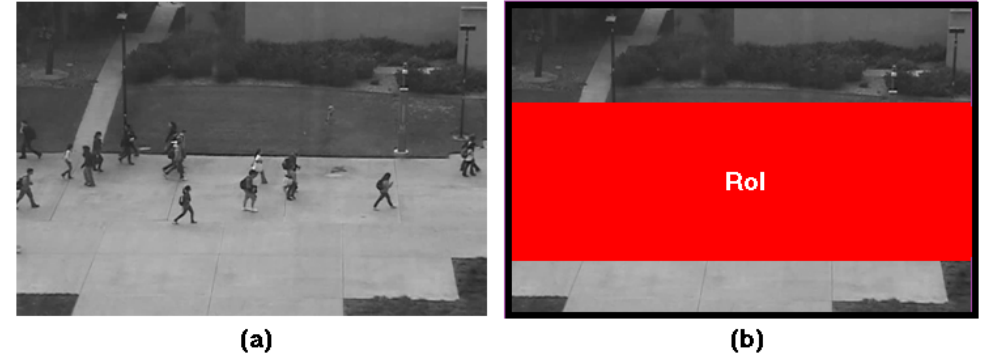
Figure 7. ( a , b ) demonstrate a camera view frame and its RoI marked red, respectively.